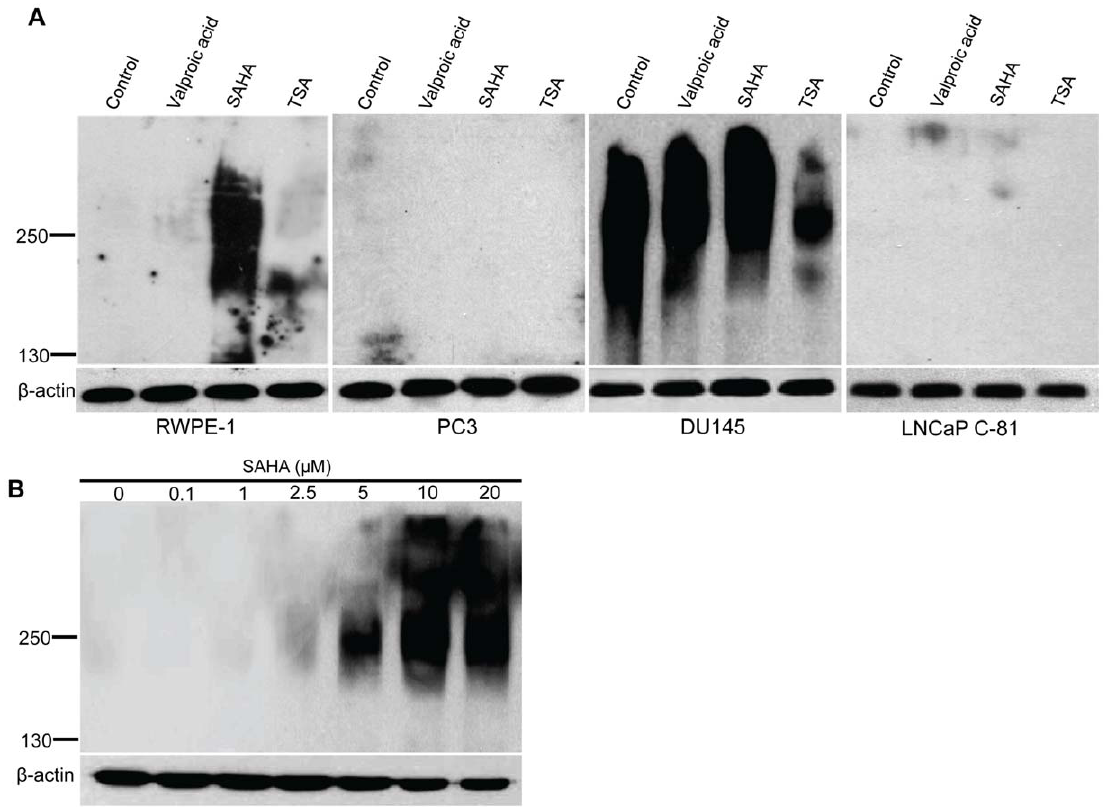
Figure 2. Effects of HDACi treatment on production of sLe a in one normal and three cancerous prostatic cells. (A) RWPE-1, PC3, DU145, and LNCaP C-81 cells were treated with 1 mM valproic acid, 20 m M SAHA or 250 nM TSA for 72 h followed by western analysis of the cell lysates for sLe a using KM231 Abs. SAHA was the only HDACi which induces marked production of sLe a in RWPE-1 cells. (B) Dose-dependent (0-20 m M) effect of SAHA on the production of sLe a in RWPE-1 cells. Minimum concentration of SAHA required to induce the production of sLe a without causing cytotoxicity is 5 m M. b -actin was used as a loading control on 10% gels and probed with anti- b -actin Abs. Experiments were performed (3x) with similar results.